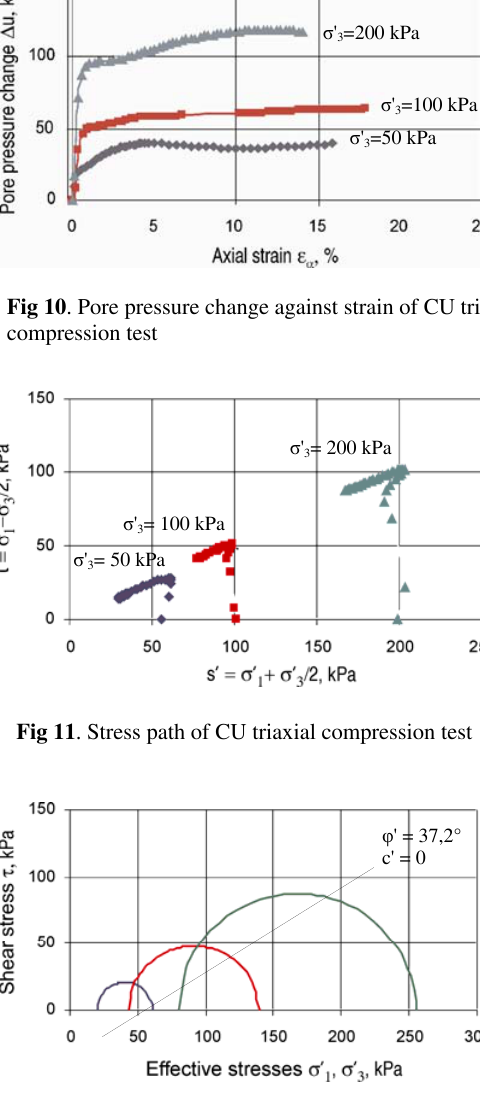
Fig 12 . Mohr circles of CU tria12xial test